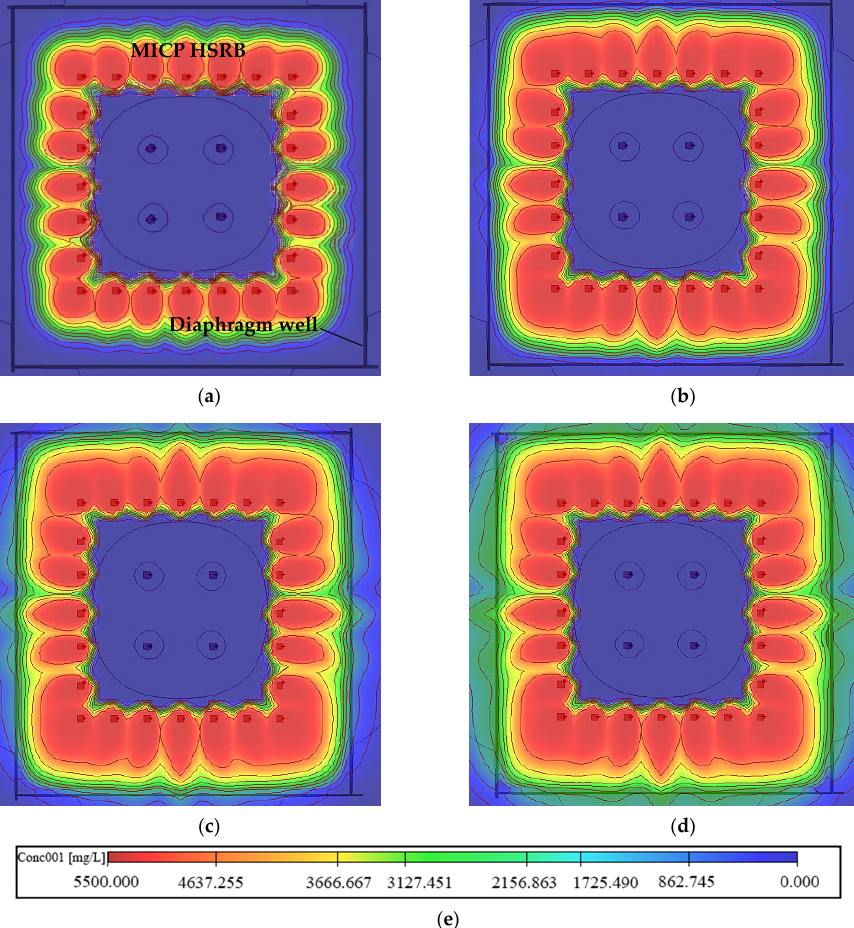
Figure 18. Horizontal migration of S. pasteurii in different time periods: ( a ) 1d; ( b ) 2d; ( c ) 3d; ( d ) 4d; ( e ) Legend.